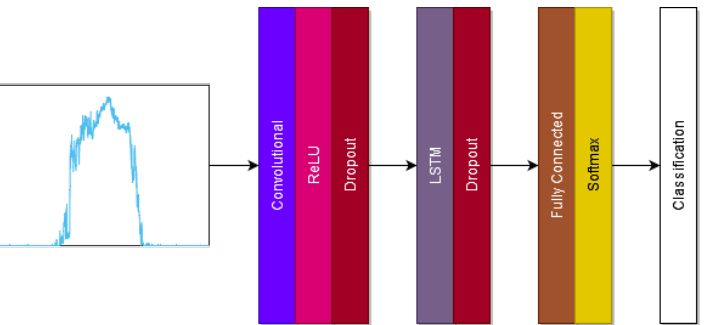
Figure 2. Neural network used for signal to phonation classification. It consists of a convolutional layer, a ReLU layer, an LSTM layer, two dropout layers, a fully connected layer and uses a softmax classifier.